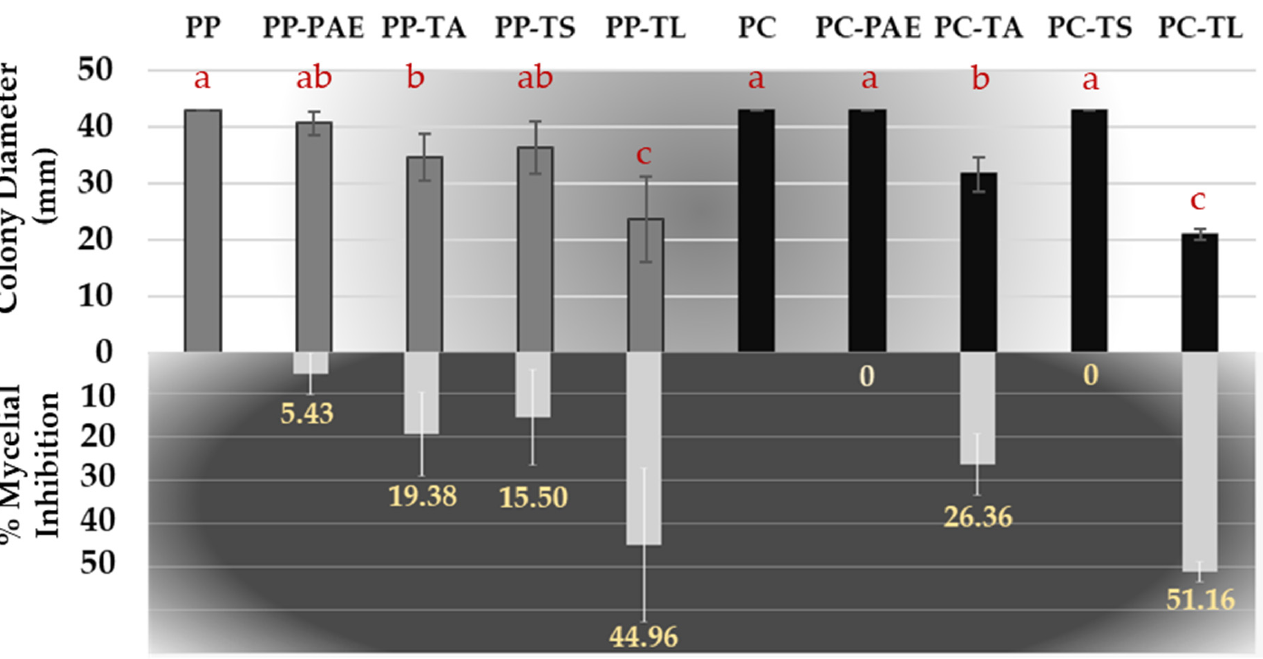
Figure 4. Colony diameter (mm) and mycelial inhibition (%) of P. parasitica (PP) and P. capsici (PC) by VOCs of T. aggressivum f. europaeum (TA), P. variotii (PAE), T. longibrachiatum (TL), and T. saturnisporum (TS). Mean values ( ± standard deviation) followed by different letters (line) indicate significant differences ( p < 0.05) using the least significant difference (LSD) test.